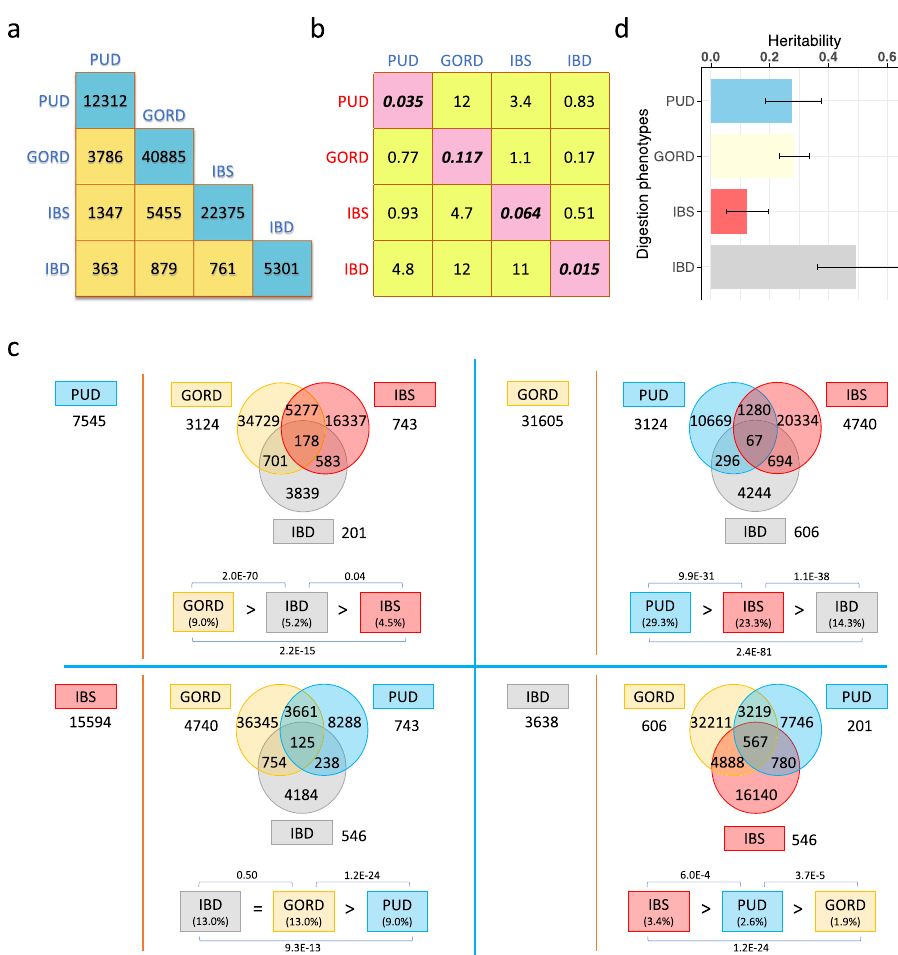
Fig. 1 Comorbidity analyses in unrelated European individuals and heritability estimation based on full-sibling relative risk for PUD, GORD, IBS, and IBD. a The number of unrelated individuals with each diagnosis (cyan boxes) and the number of overlapped individuals between each pair of PUD, GORD, IBS, and IBD cases (yellow boxes). These differ from Table 1 because only unrelated individuals are considered here. b Cells represent ratio of the odds of disease cases from each column in those with disease from each row and the odds of each row disease cases in unrelated European-ancestry individuals. The diagonal elements are the sample risk rates and differ from “ N case/( N case + N control) ” in Table 1 because only unrelated individuals are included here. c Competitive comorbidity analyses for each of PUD, GORD, IBS, and IBD disease (de fi ned, in turn, as index disease) to test among the other three diseases which disease is more prone to be comorbid with the index disease. The disease on the left of the red dashed line is the index disease and the number shows the number of cases without any comorbidity. The corresponding Venn diagram shows the number of individuals with recorded or self- report diagnosis with at least one of the other three diseases. The numbers outside of the Venn diagrams are the numbers of individuals with diagnosis of both the index disease and each of the other three diseases in turn, after removing the overlapped individuals for these three diseases. At the bottom of each Venn diagram is the proportion of the index disease cases in the other three diseases respectively, compared in pairs using a two-proportion Z test to test which disease is more prone to be comorbid with the index disease. d Heritability estimates and 95% con fi dence interval for PUD, GORD, IBS, and IBD based on full-sibling relative risk. See the Supplementary Note 1 for an example explaining b , c